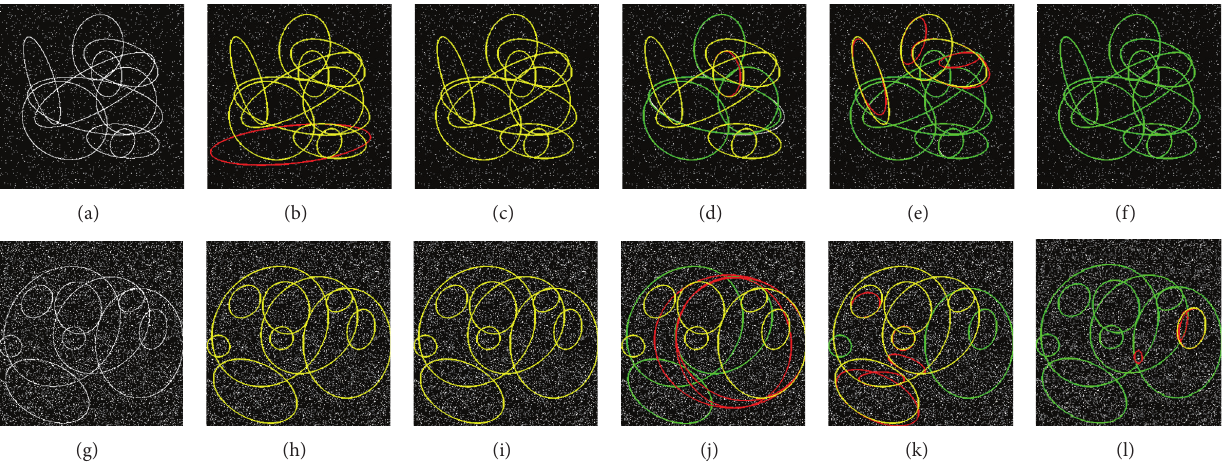
Figure 12: Two sets of detection results by each method. (a, g) are two images with 5% and 20% salt and pepper noise, (b, h), (c, i), (d, j), (e, k), and (f, l) are the detection results by RHT, UPW, KIM, MAI, and the proposed method, respectively, where the meaning of each color is the same as Figure